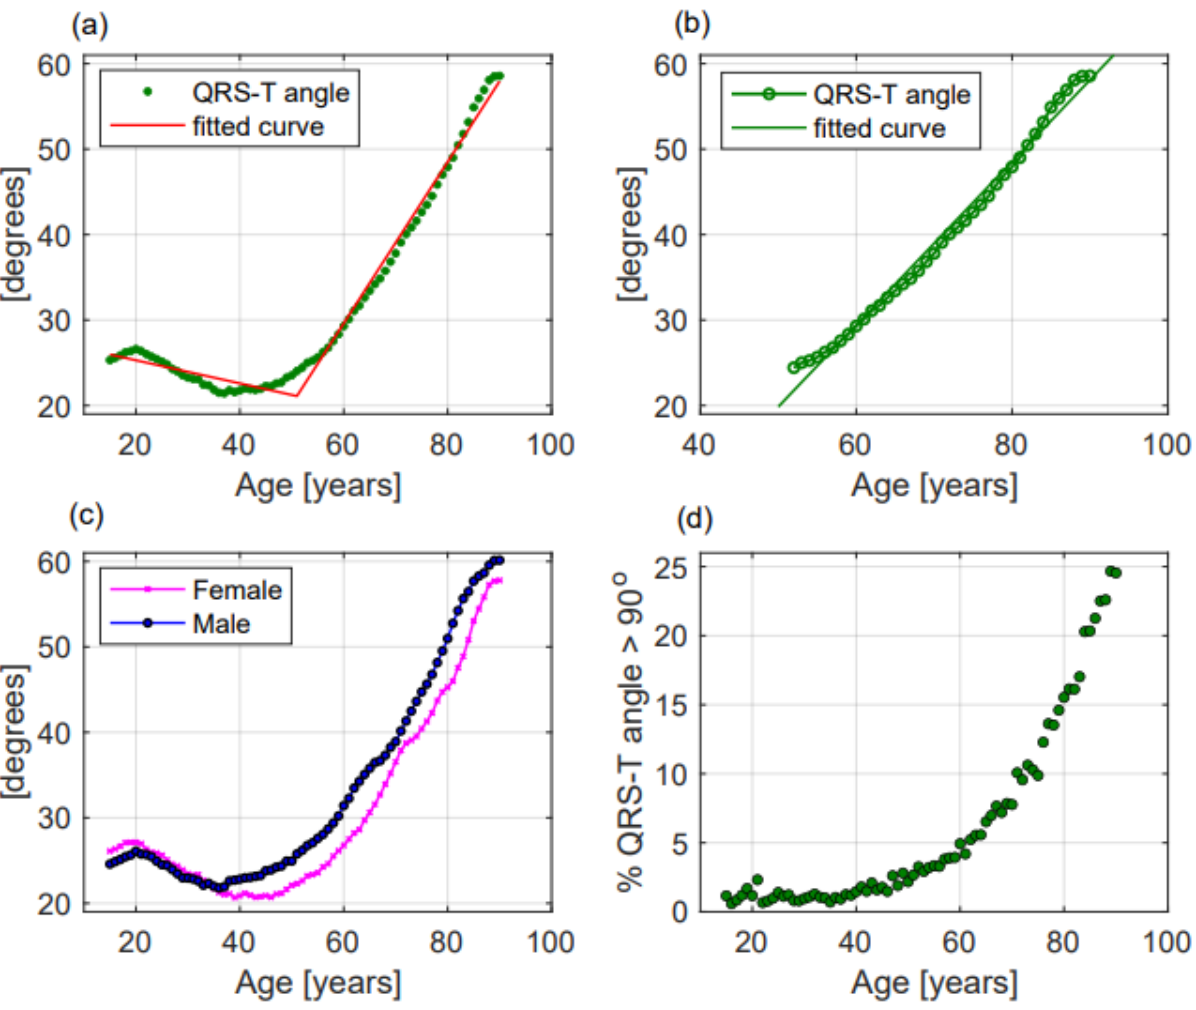
Figure 4. QRS-T angle modifications with ageing in the whole population ( a ), in patients older than 51.5 years ( b ), in females and males ( c ); and ( d ) percentage of patients with QRS-T angle greater than 90 deg according to age. In panels ( a – c ) dots represent mean values of QRS-T angle while in panel ( d ) green dots represent the percentage of patients with a QRS-T angle greater than 90 deg. In panels ( a , b ) lines represent the fitted curve.